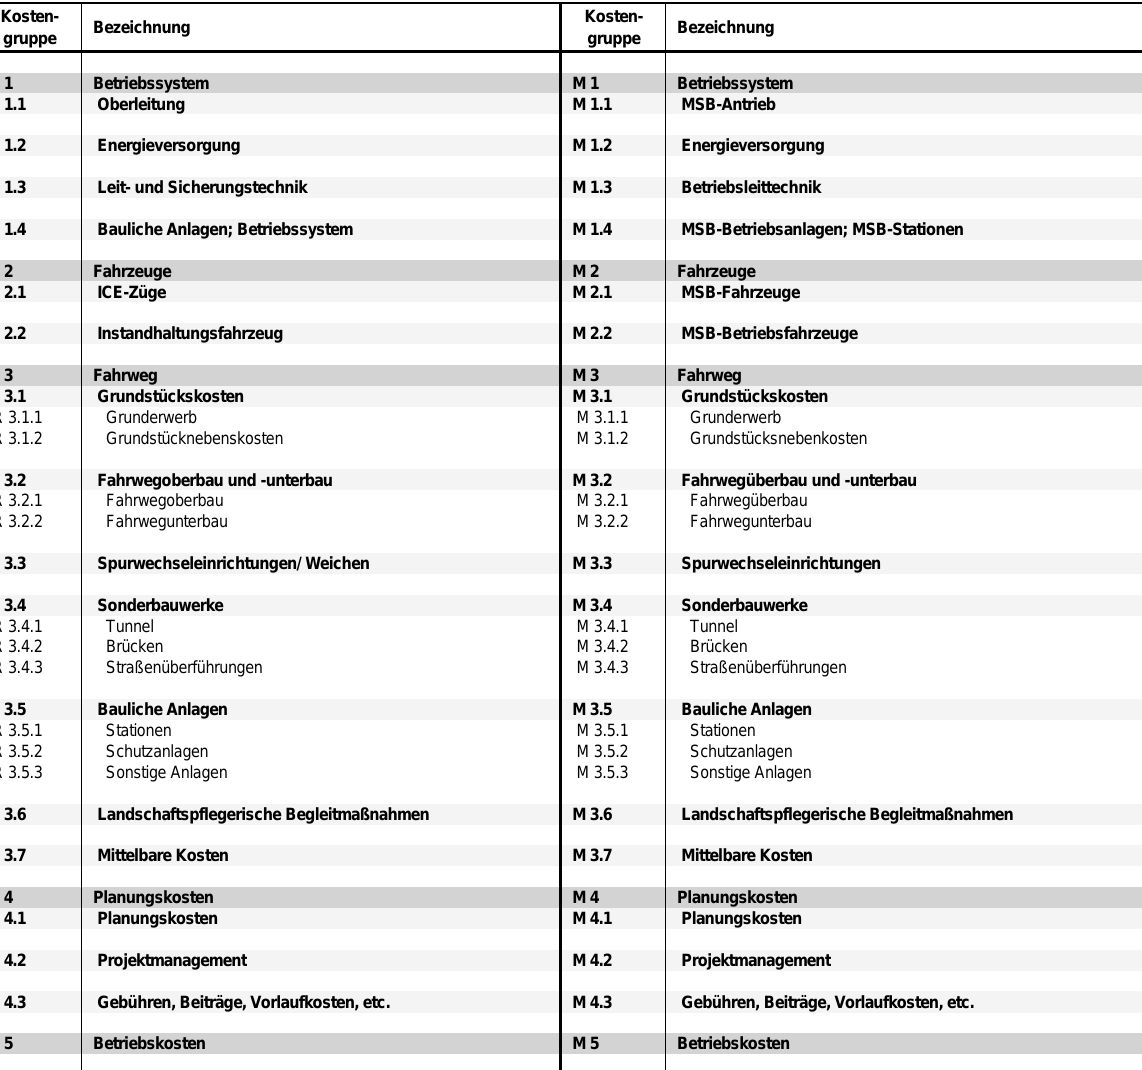
Table 4. Cost structures for the high-speed railway and the Maglev system